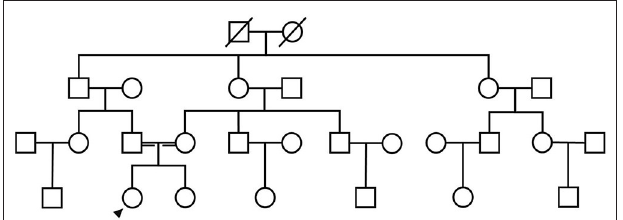
FIGURE 1 | The patient’s family diagram shows that the patient’s parents were cousins, and the patient (black arrow) was the only SMA patient in the family.